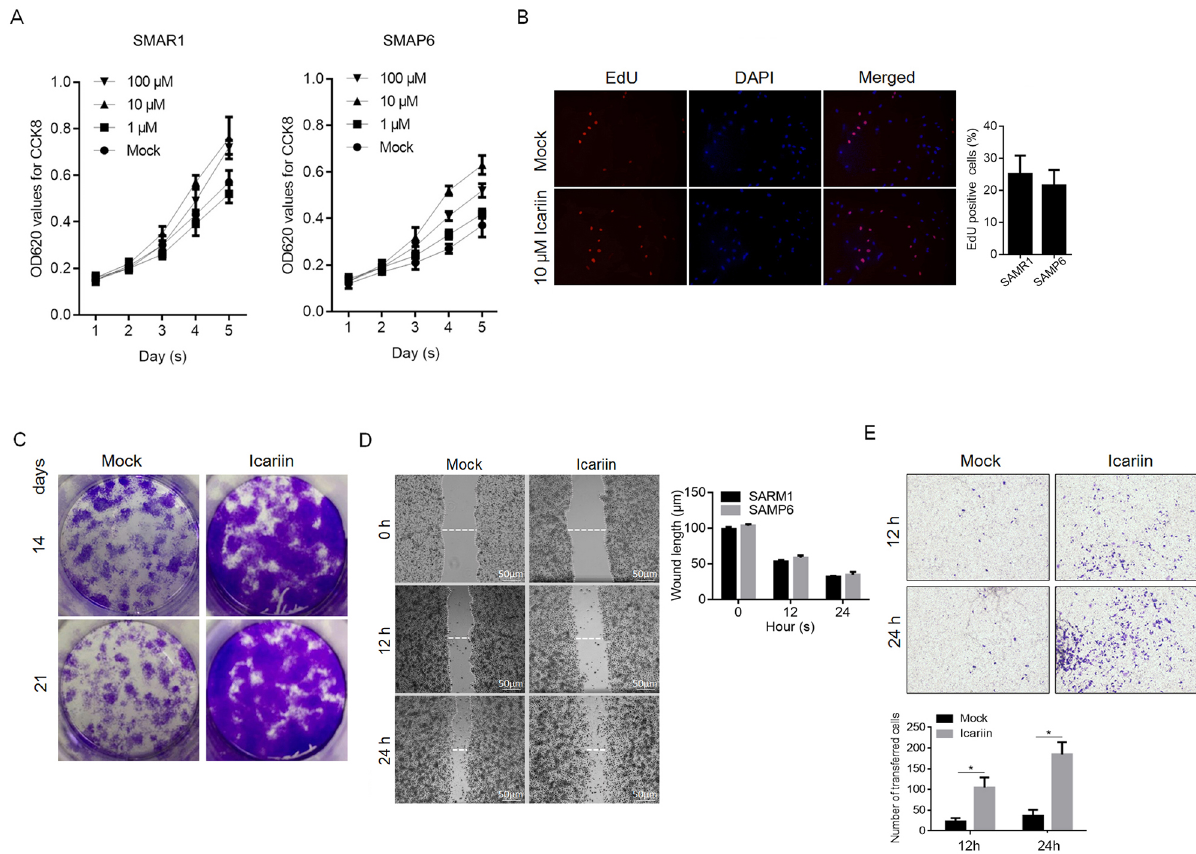
Fig 3. Icariin enhances SAMP6 osteoblast proliferation and migration. After icariin treatment, cell viability (A), cell proliferation (B & C) and migration (D & E) were analyzed in SAMP6 osteoblasts. (cid:3) P < 0.05 vs. Mock group.